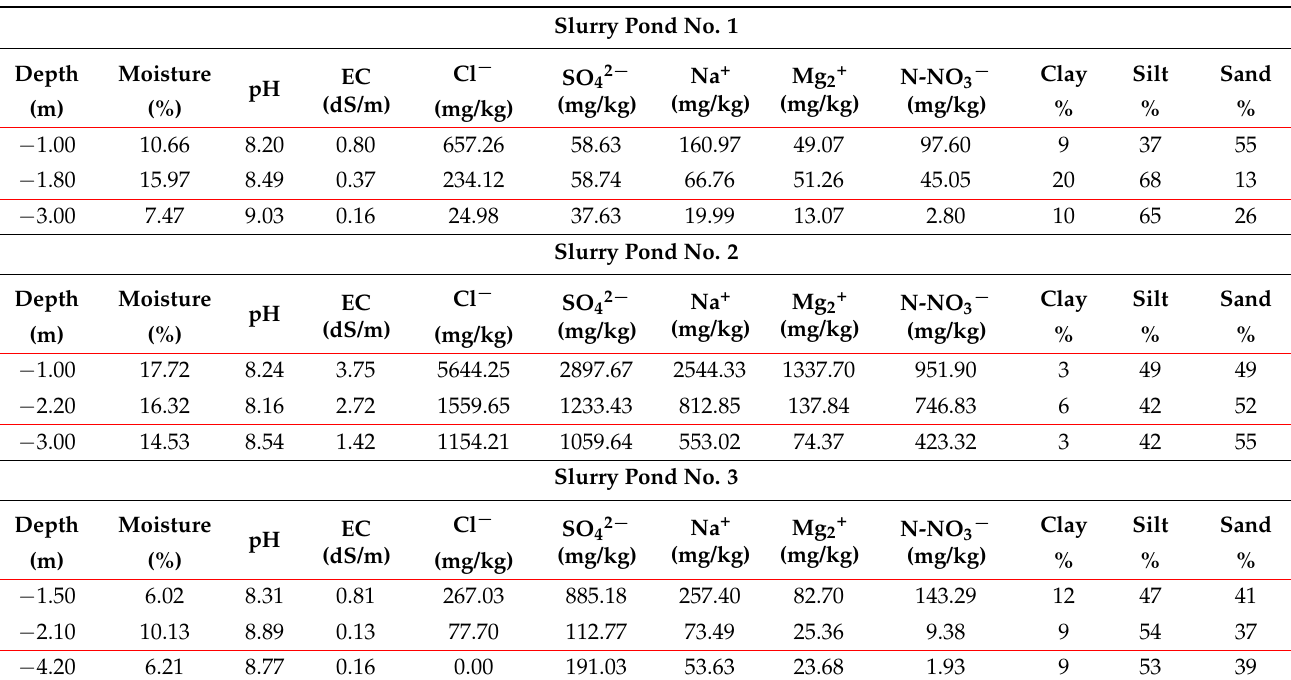
Figure 6. Lithology columns from drilling operations in ( a ) slurry pond No. 1, ( b ) slurry pond No. 2, and ( c ) slurry pond No. 3. Table 1. Main values from geochemical analysis on soil samples. The increase observed in the two-meter depth in the main parameters is framed.